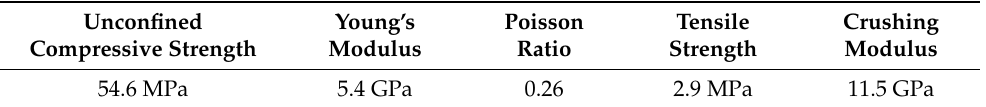
Table 1. Physical parameters of gypsum.